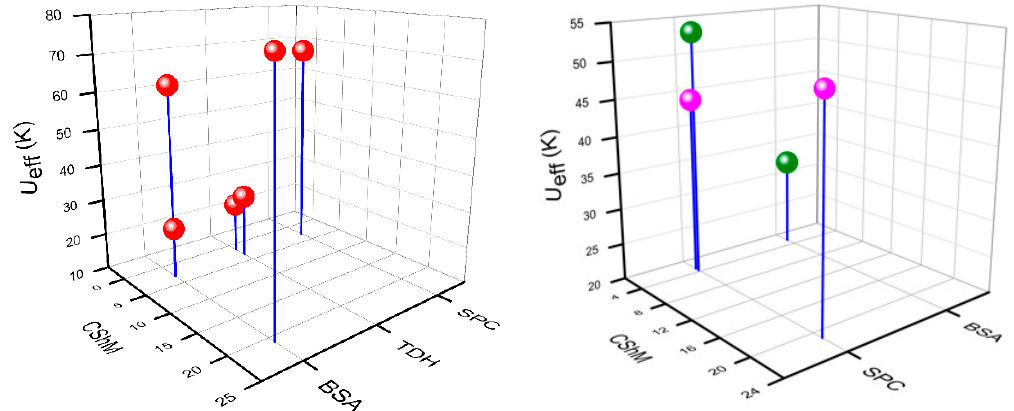
Figure 28. ( left ) Geometry and magnitude dependent experimentally found effective energy barrier for (DyO10) systems; ( right ) for (DyO6N4) systems (magenta color spheres), and for (DyO4N6) systems (green color spheres).